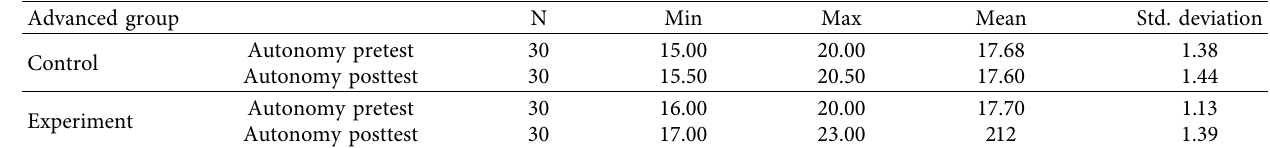
Table 18: Descriptive statistic for writing skill in advanced groups.